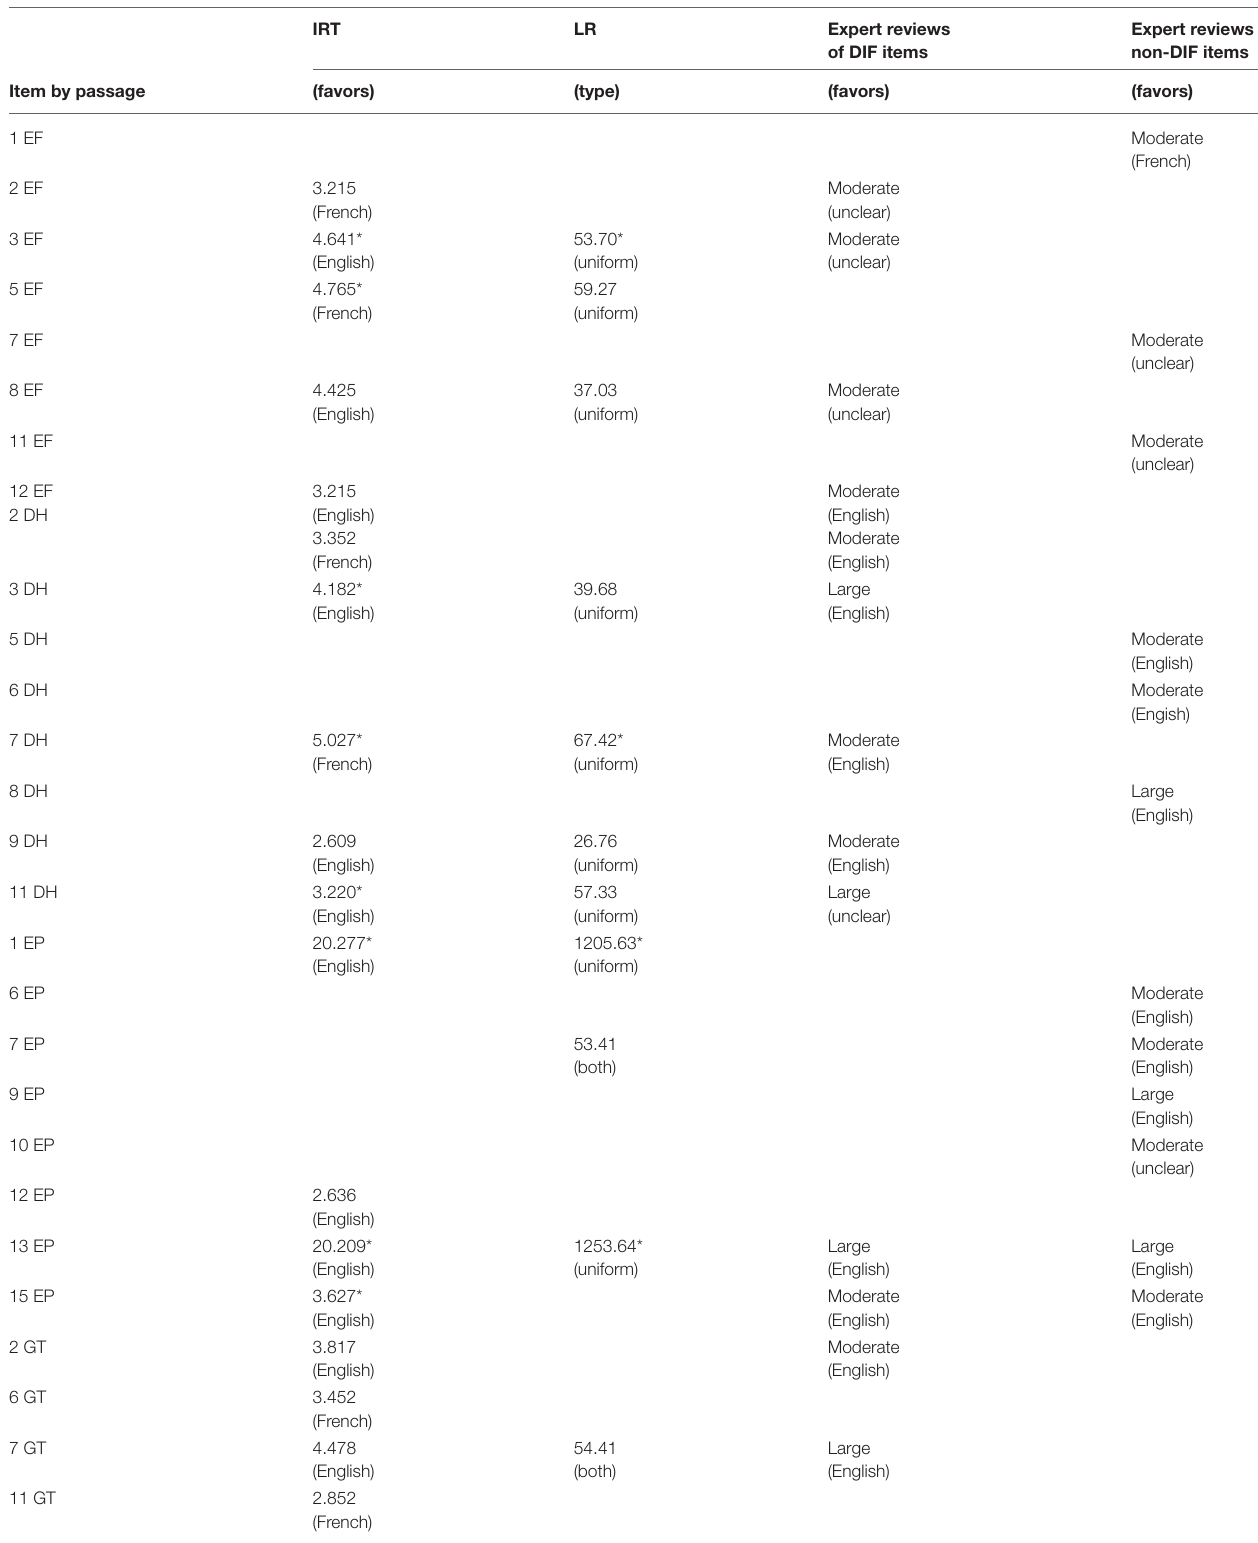
TABLE 9 | Consistency between expert reviews and statistical methods by passage. IRT